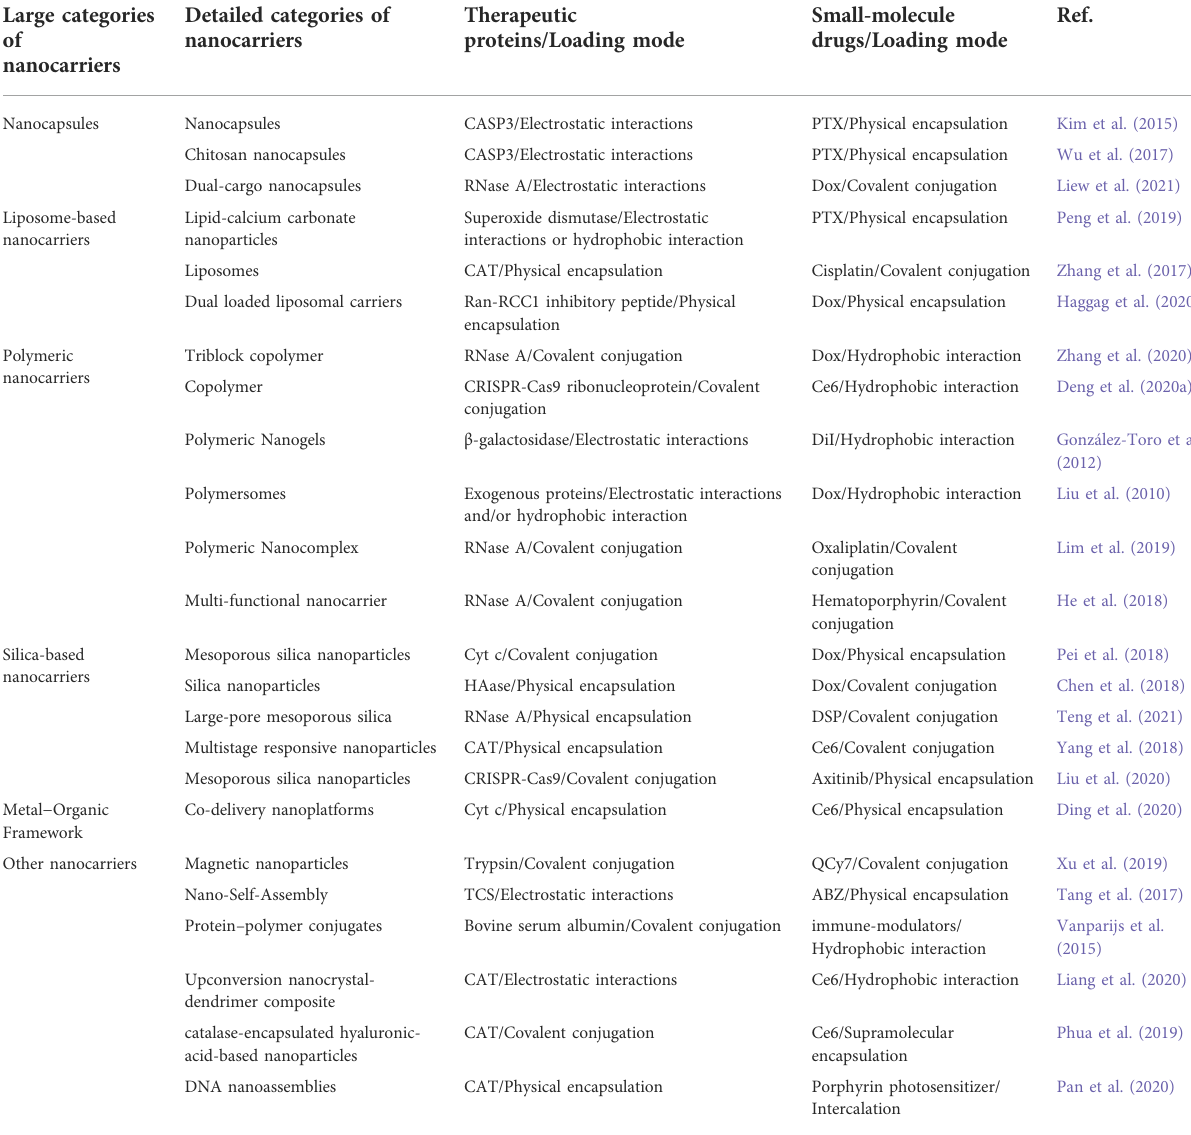
TABLE 1 Summary of recently reported intracellular co-delivery nano-systems of proteins and drugs for tumor